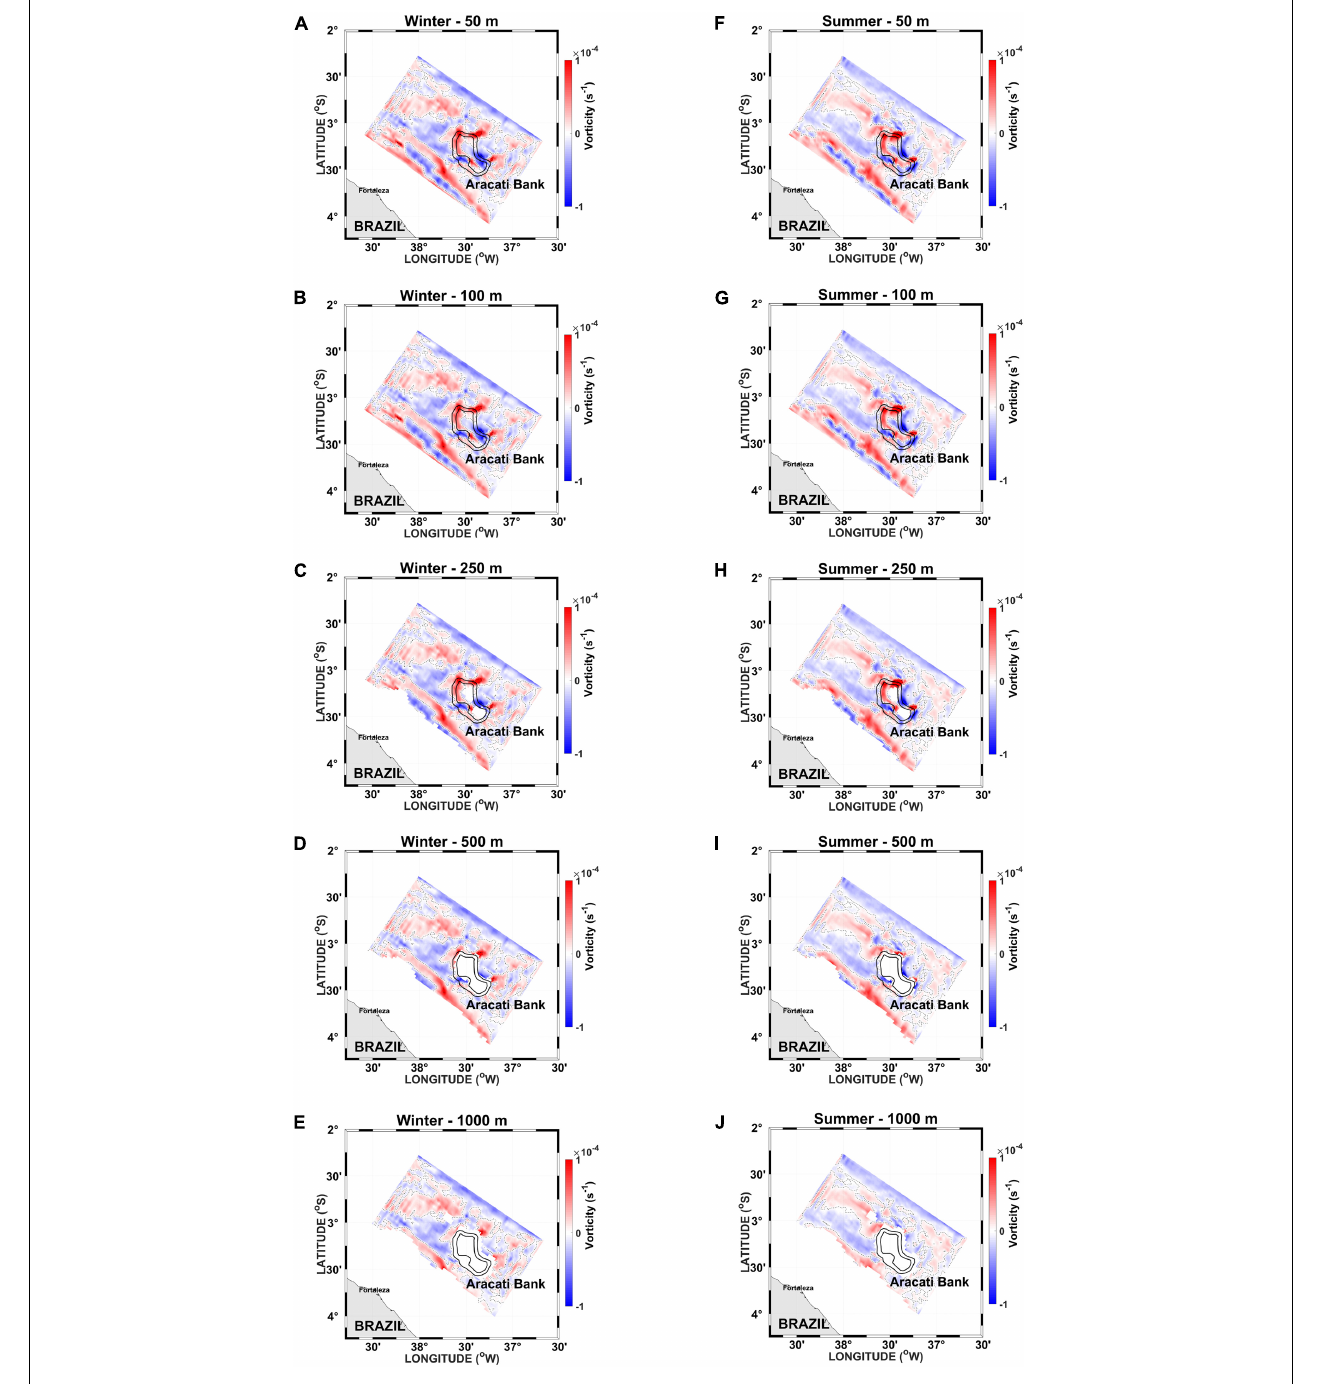
FIGURE 8 | Vertical vorticity (s - 1 ) in the Aracati Bank area at depths of 50, 100, 250, 500, and 1,000 m during winter (A–E) and summer (F–J)